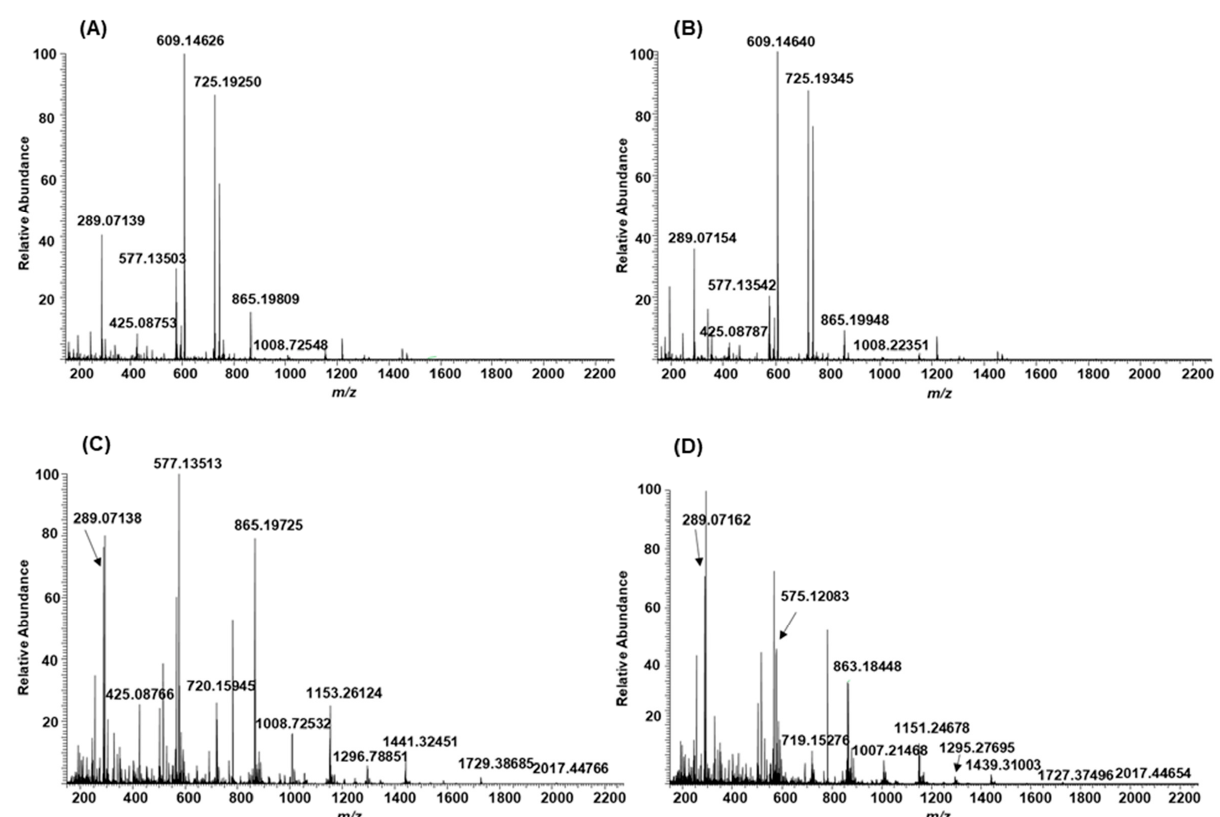
Figure 6. Total mass spectra of non-oxidized ( A ) and oxidized ( B ) leaf extract of Begonia bowerae “Nigra” and of non-oxidized ( C ) and oxidized ( D ) leaflet extract of Cyperus owanii . The exact masses of main ions of proanthocyanidins are listed in Tables S1 and S2.